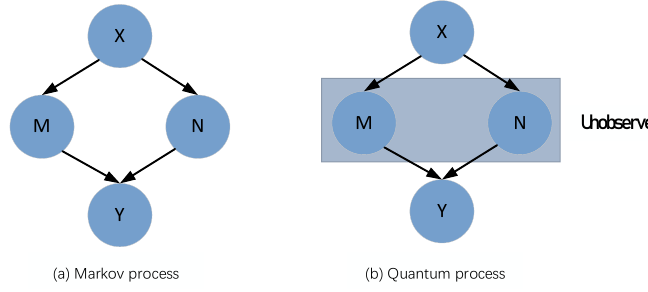
Figure 3. Path selection of decision state transition.